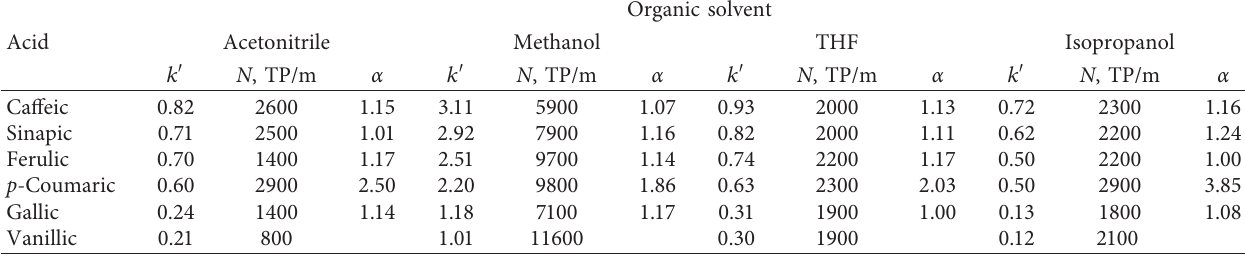
Figure 3: PA retention factors from buffer pH at SP-1 sorbent. Acids (100 μ g/ml):1, caffeic; 2, sinapic; 3, ferulic; 4, p -coumaric; 5, salicylic; 6, syringic; 7, gallic. Table 1: Effect of the nature of the organic solvent in the mobile phase composition on the PA retention and the efficiency of the SP-1 column.